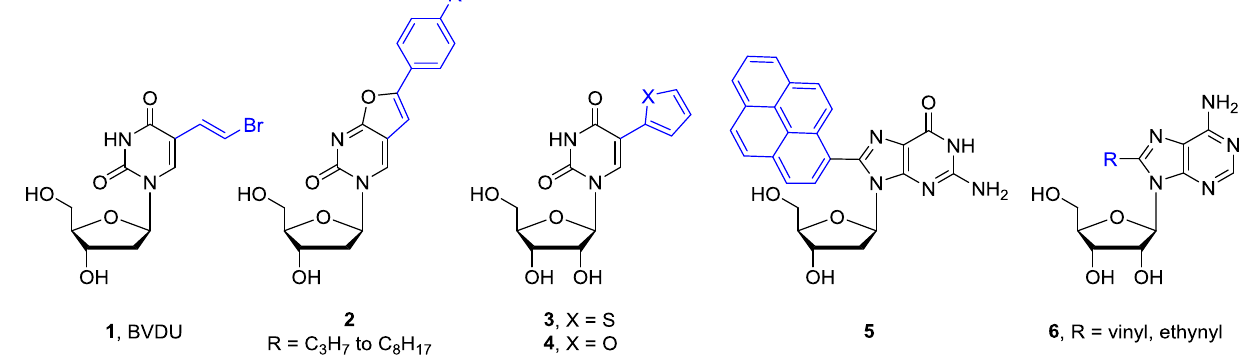
Figure 2. Selected base-modified pyrimidine and purine